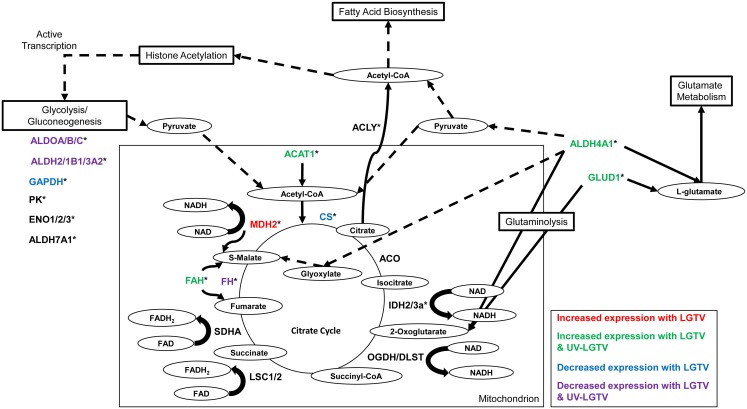
Citrate cycle showing ISE6 proteins that exhibited increased/decreased expression following treatment to LGTV and UV-LGTV.The enzymes are indicated with KEGG abbreviated nomenclature and the corresponding substrates are shown in circles. * denotes proteins identified in this study. Dotted lines denote indirect involvement with production. The increased expression of malate dehydrogenase (MDH2) is unique to LGTV-treated cells while increase in the expression of acetyl-CoA acetyltransferase 1 (ACAT1), delta-1-pyrroline-5-carboxylate dehydrogenase (ALDH4A1), glutamate dehydrogenase (GLUD1), and fumarylacetoacetase (FAH) is common to cell samples following LGTV infection and UV-LGTV treatment. Decreased expression of citrate synthase (CS) and glyceraldehyde-3-phosphate dehydrogenase (GAPDH) was observed in LGTV-treated cells and decreased expression of fumarate hydratase (FH), aldolase A/B/C fructose-bisphosphate (ALDOA/B/C), and aldehyde dehydrogenase 2/1B1/3A2 family protein (ALDH2/1B1/3A2) was observed in both LGTV-infected and UV-LGTV—treated cells. ATP citrate lyase (ACLY), aconitase (ACO), isocitrate dehydrogenase 2/3a (IDH2/3a), oxoglutarate/alpha-ketoglutarate dehydrogenase complex (OGDH/DLST), succinyl-CoA synthetase alpha/beta subunit (LSC1/2), succinate dehydrogenase flavoprotein subunit (SDHA), pyruvate kinase (PK), enolase 1/2/3 (ENO1/2/3), and aldehyde dehydrogenase 7A1 family protein (ALDH7A1).